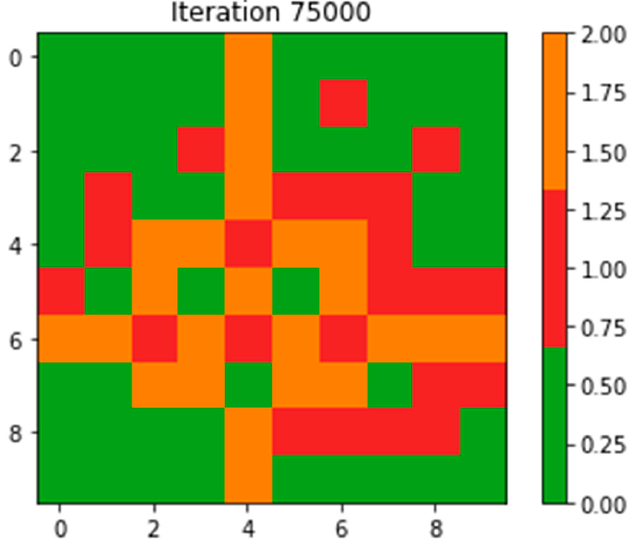
Figure 9. Labeled map obtained at final iteration.